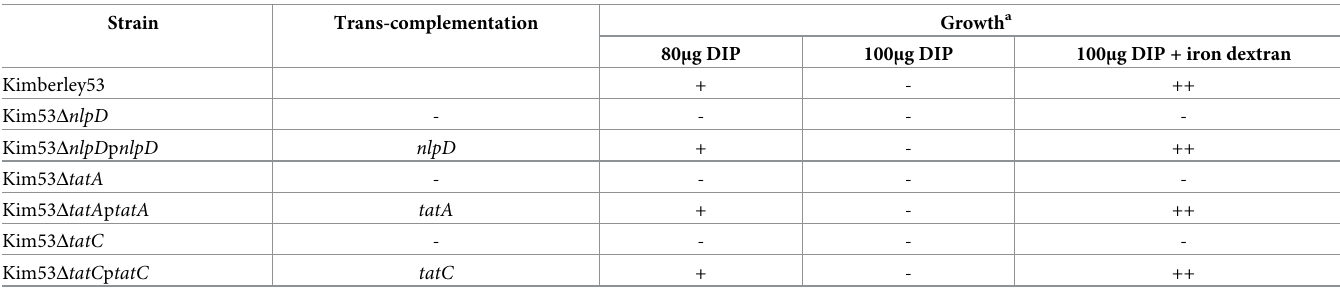
Table 2. Growth of Y . pestis strains under iron-limiting conditions. Strain